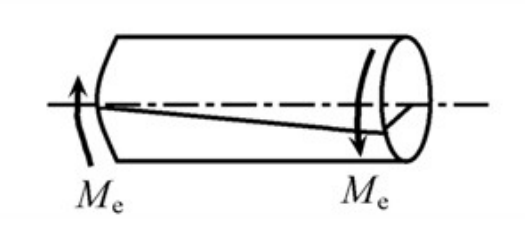
Fig. 6 Torsional deformation of rod.